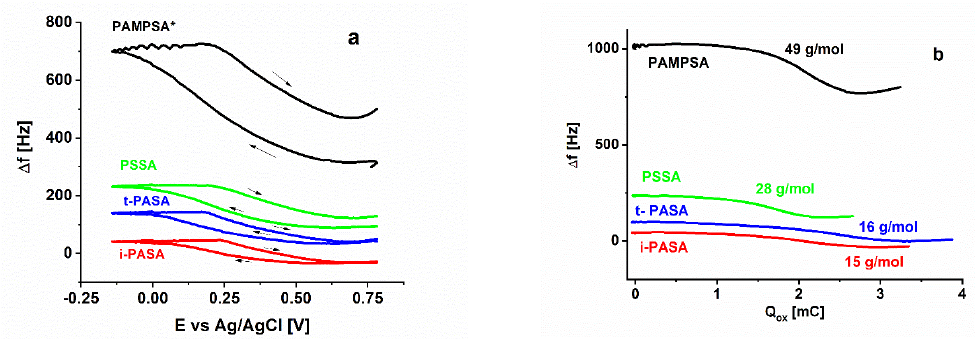
Figure 4. Frequency change in the course of electrochemical redox switching of thick PANI layers obtained in the presence of PAMPSA (black), t-PASA (blue), i-PASA (red) and PSSA (green): ( a ) as function of potential and ( b ) as function of oxidation charge.